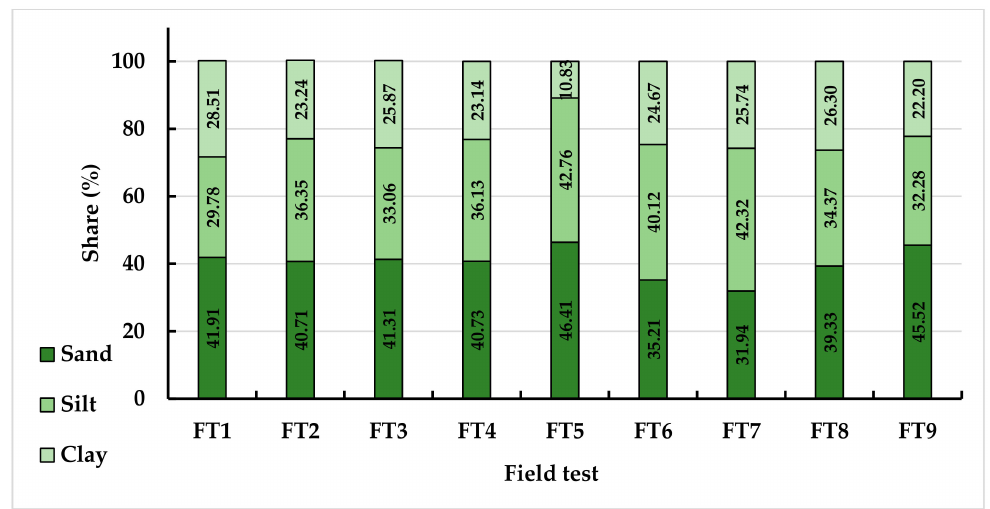
Figure 4. Granulometric distribution of forest soils in the analyzed field tests. Legend: FT1 to FT9 stand for the field tests 1 to 9.